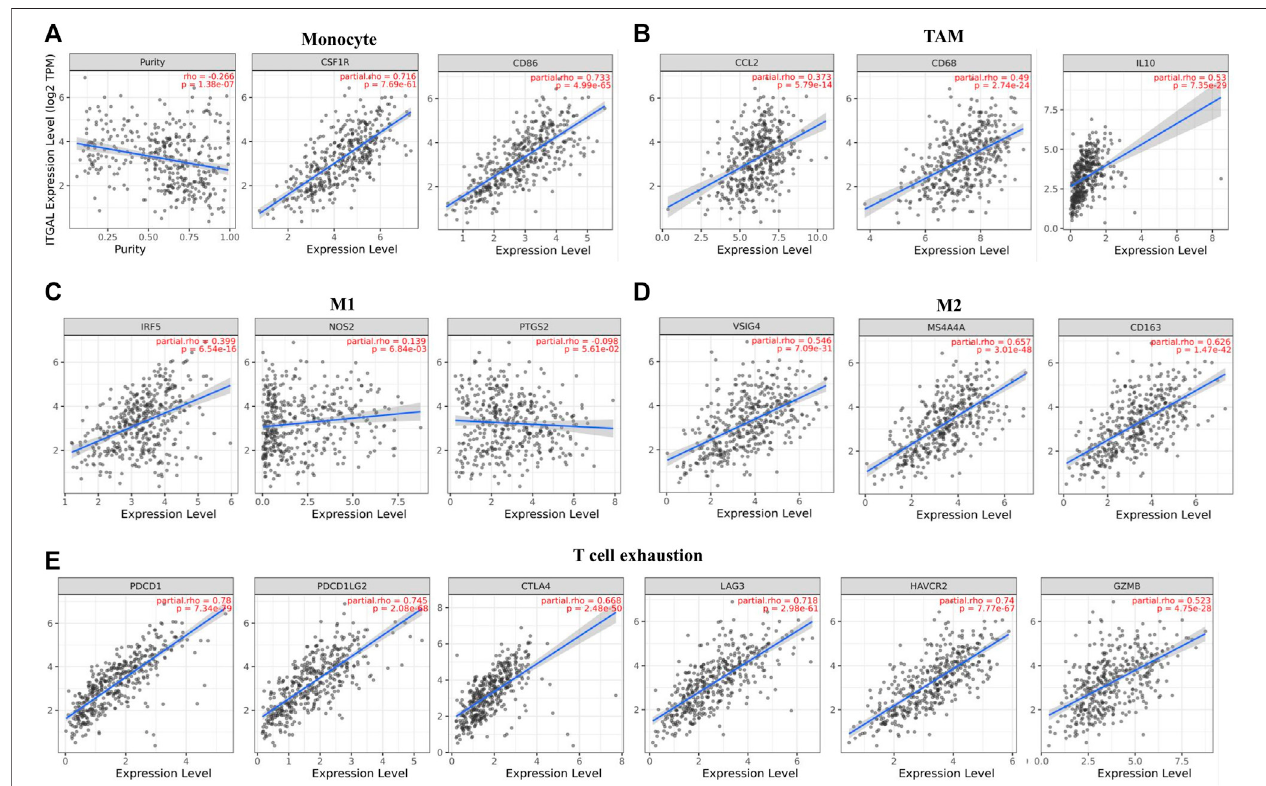
FIGURE 5 | ITGAL expression correlated with monocyte, macrophages, and T cell exhaustion in stomach adenocarcinoma (STAD). Markers include CD86 and CSF1R of monocytes; CCL2, CD68, and IL10 of TAMs; NOS2, IRF5, and PTGS2 of M1 macrophages; and CD163, VSIG4, and MS4A4A of M2 macrophages. Scatterplots of correlations between ITGAL expression and gene markers of monocytes (A) , TAMs (B) , and M1 (C) , M2 macrophages (D) and T-cell exhaustion (E) in STAD ( n = 415).